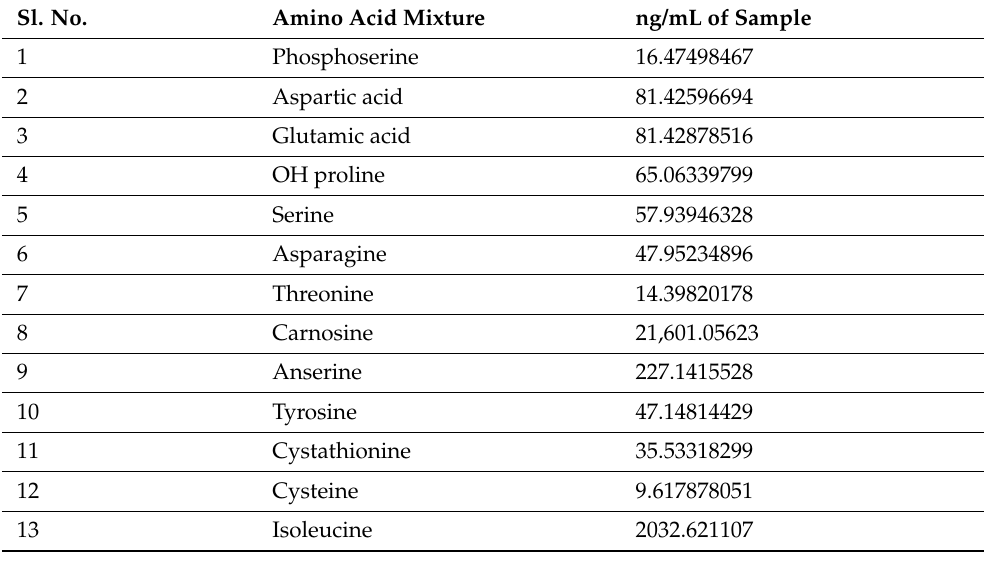
Table 4. TAA content in R. faecalis N Raju MPPR (HPLC).